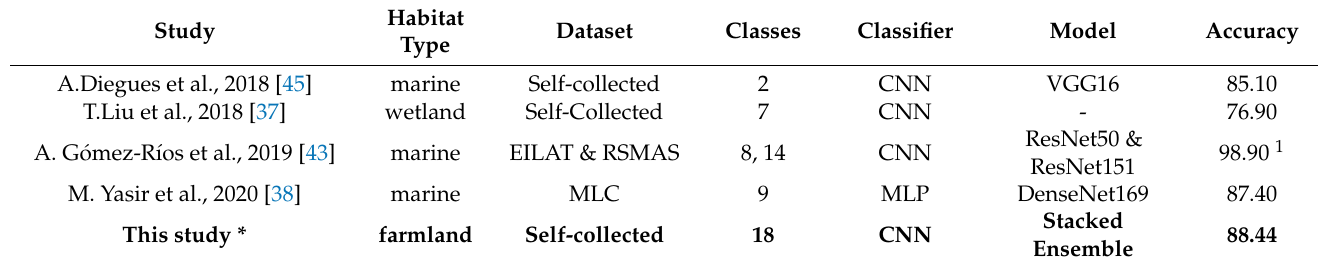
Table 6. Comparison of results with other recent state-of-the-art